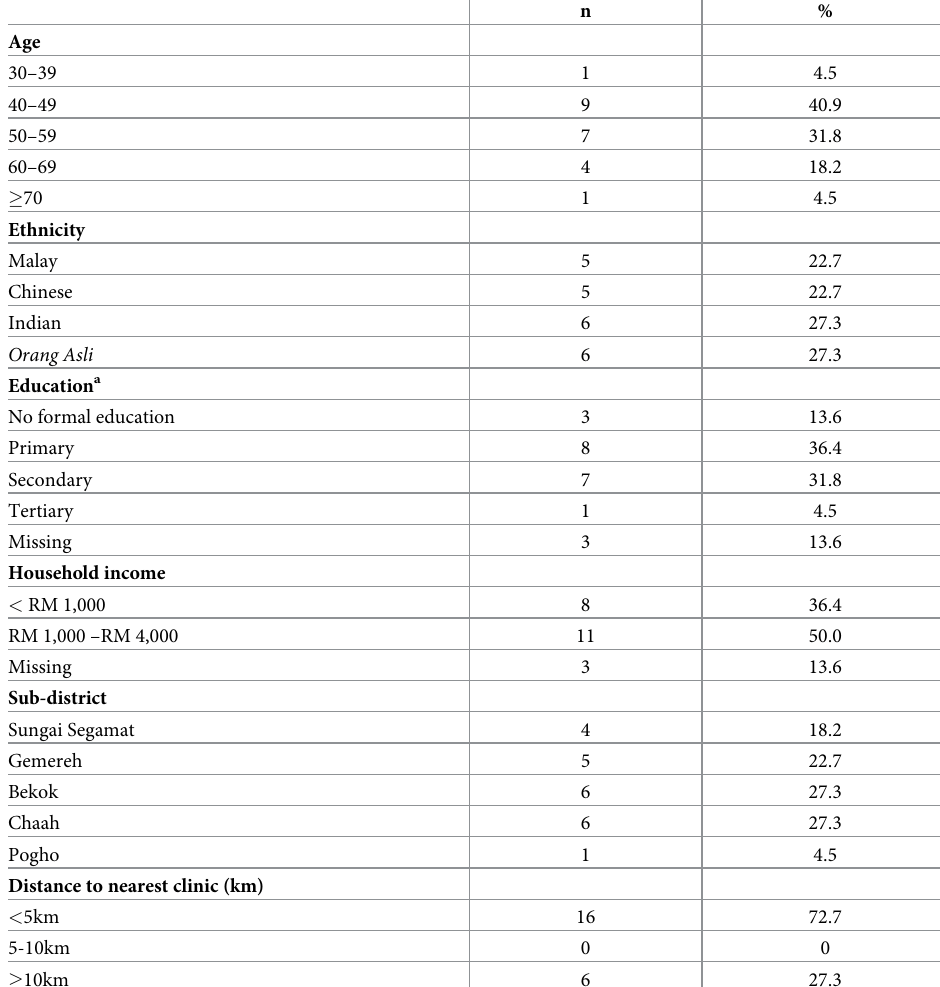
Table 2. Socio-demographic information from FGD participants (n =